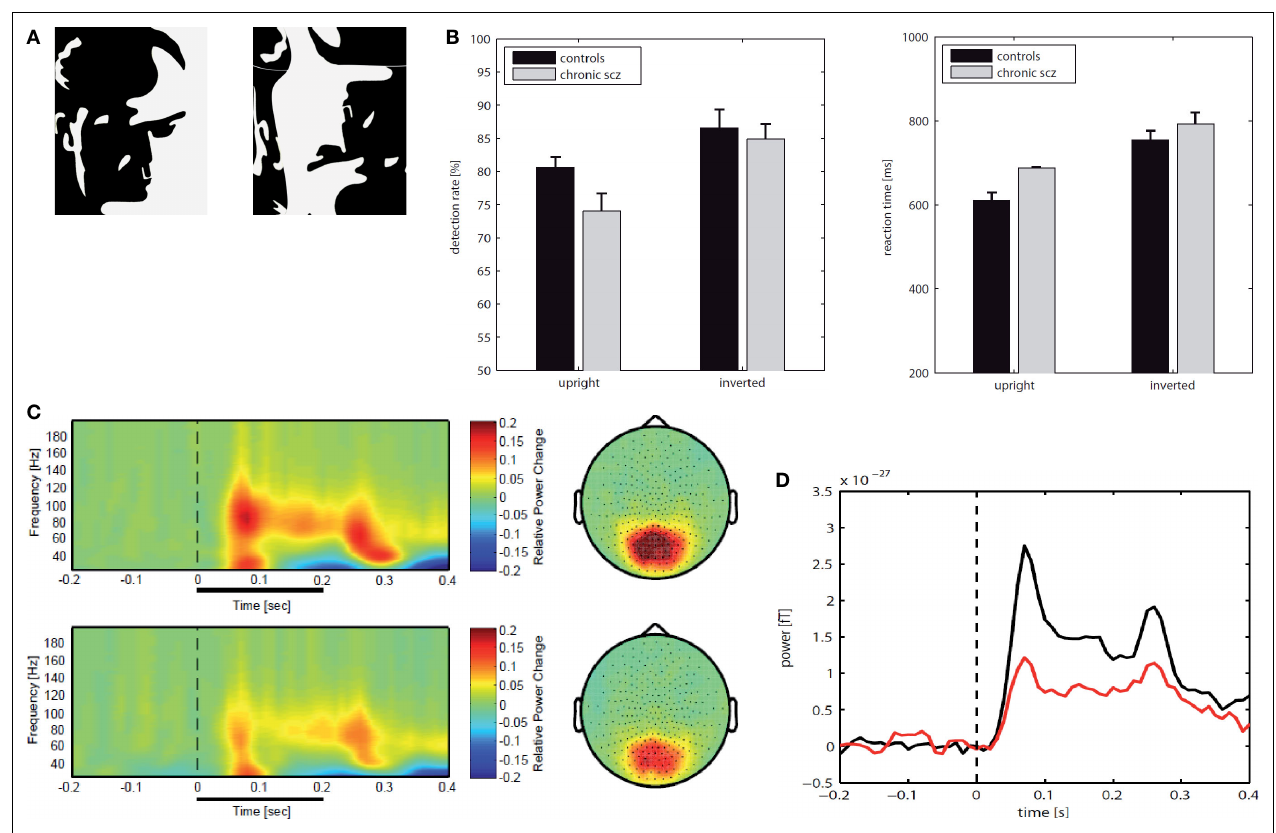
Mooney faces in the frequency range 25–200 Hz over parietal sensors; Top: normal controls, Bottom: patients with schizophrenia. (D) Time course for gamma-power (60-120 Hz) for parietal sensors during the perception of upright Mooney faces (red: schizophrenia patients; black: